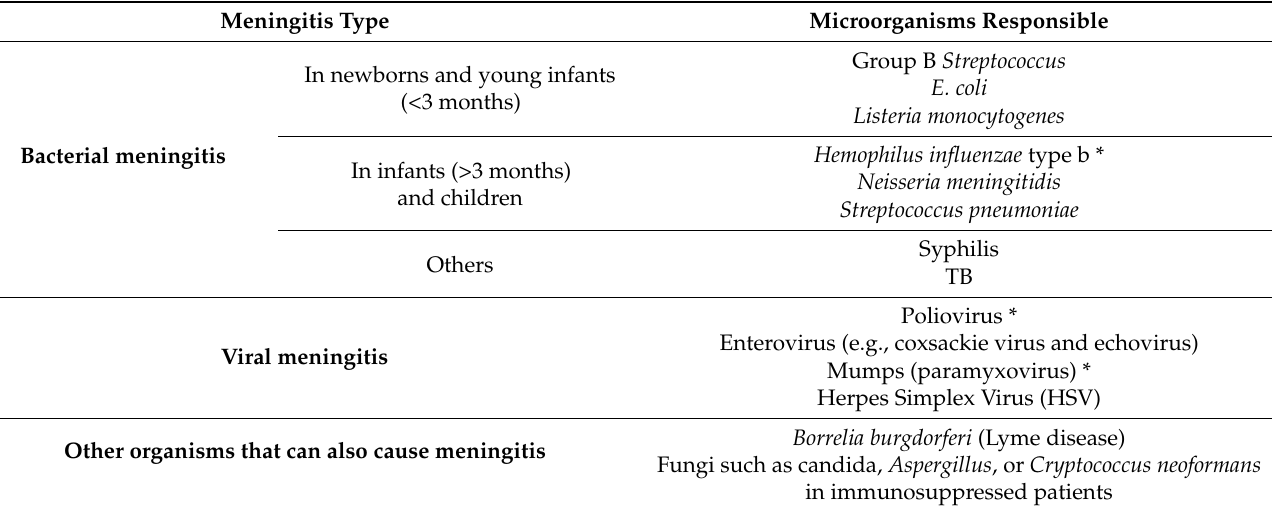
Table 5. Different causal pathogens of